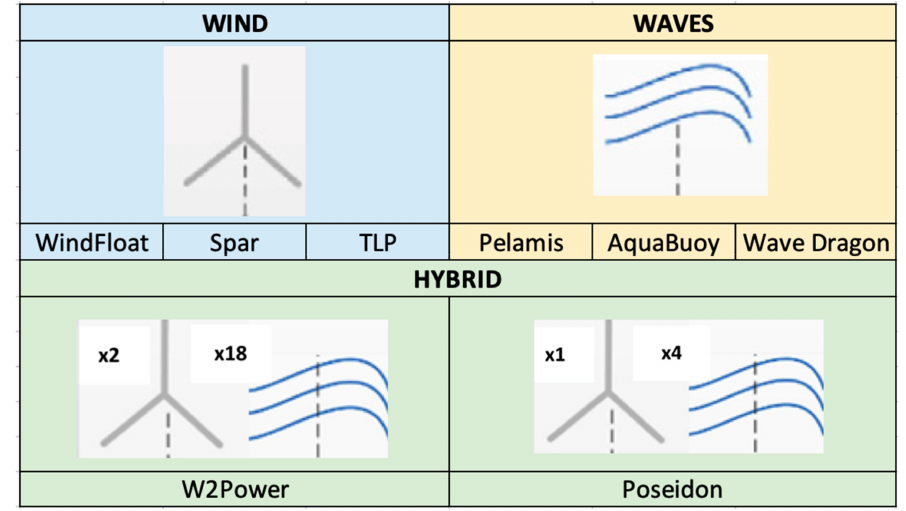
Figure 4. Type of floating platform inputs: wind (WindFlaot, spar, TLP), waves (Pelamis, AquaBuoy, Wave Dragon) and Hybrid (W2Power, Poseidon).